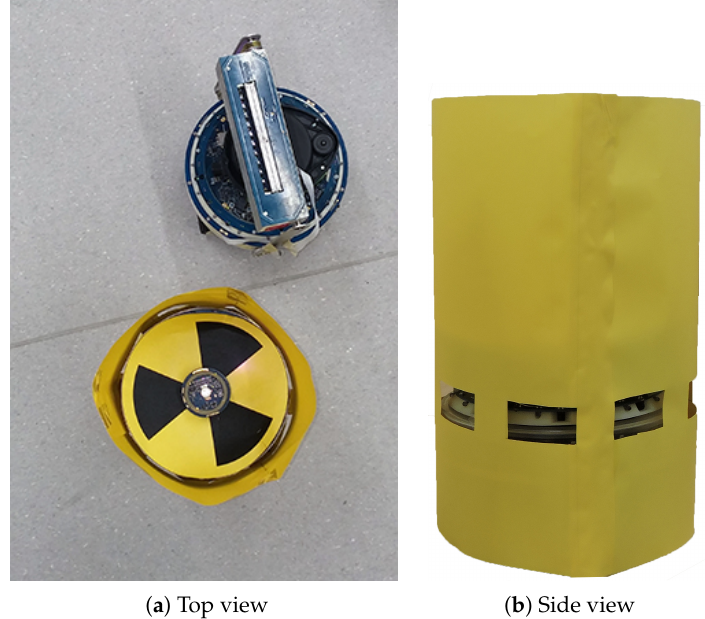
The source is another marXbot in which the range and bearing system acts as a radioactive